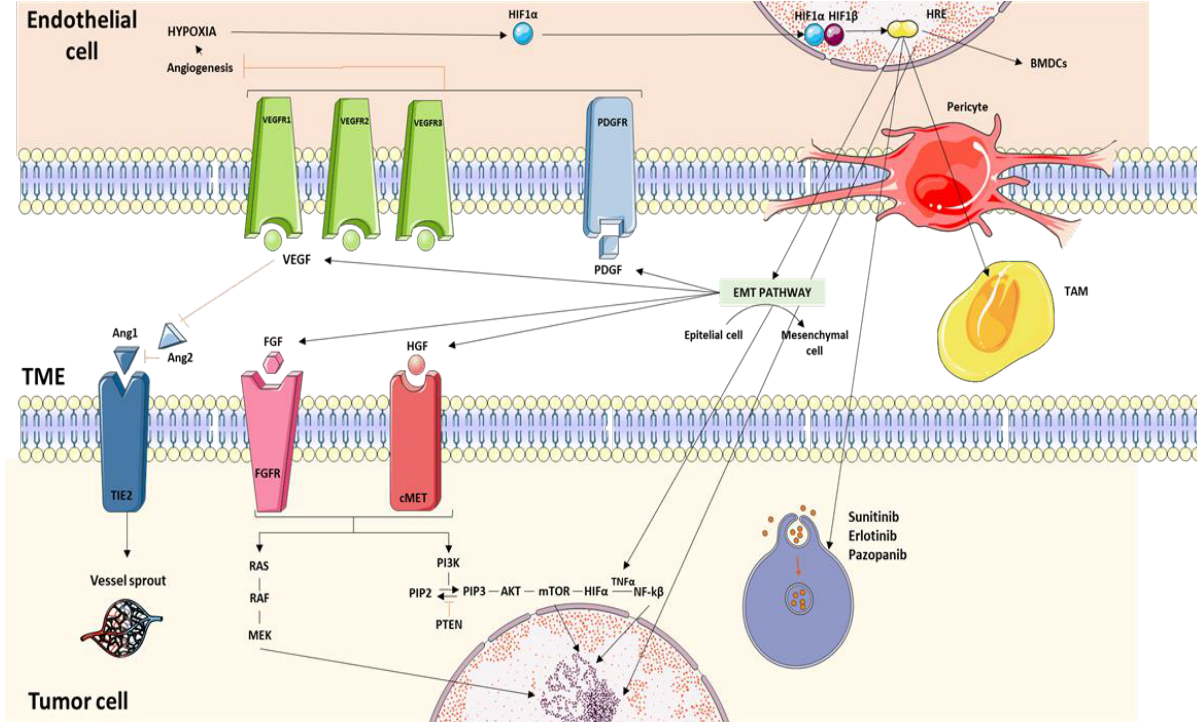
Figure 1. In this figure we illustrate the most preponderant mechanisms of resistance to TKIs: hypoxia-induced activation of alternative proangiogenic pathways, TME factors, EMT, and TKI-induced autophagy.